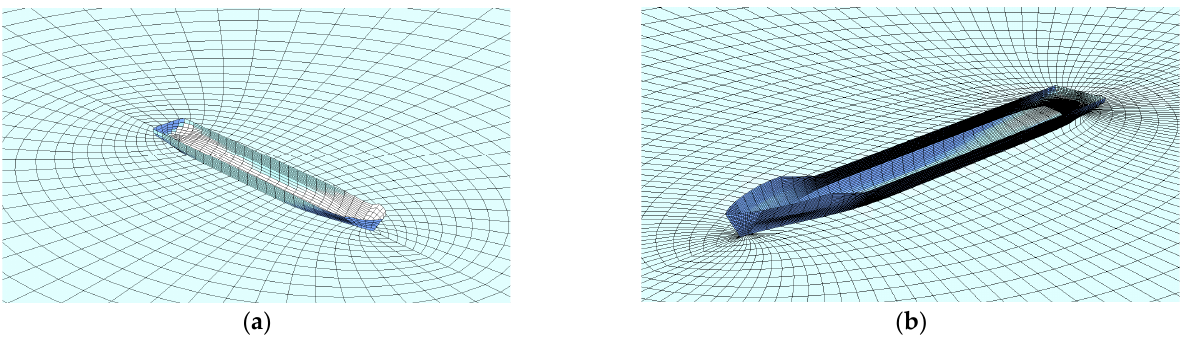
Figure 4. Panel meshes for PF solution for both cases: ( a ) 6750 TEU containership mesh; ( b ) KRISO containership mesh.